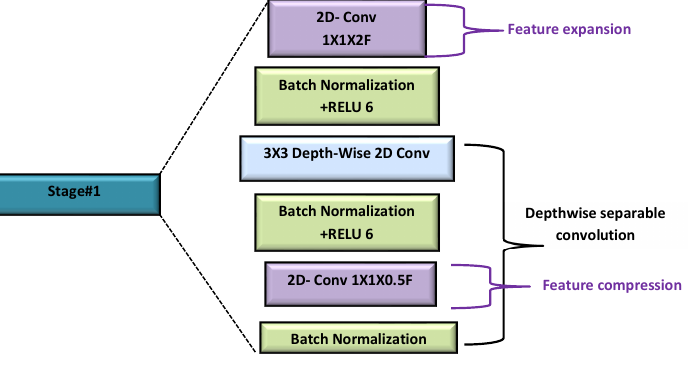
Figure 4. Architecture of the “Stage” block. Table 1. Classifier Training, validation and test accuracy and loss on a core i7-4790 @ 3.6 GHz